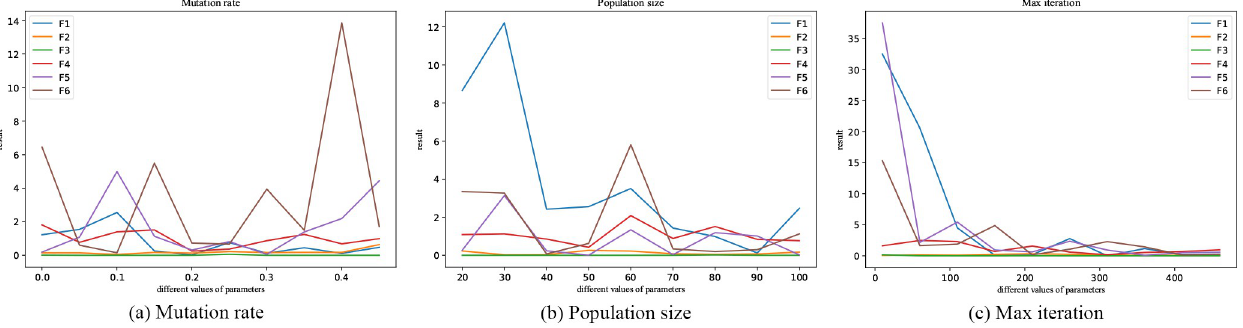
Fig 2. IGA parameters selection. (a) Mutation rate. (b) Population size. (c) Max